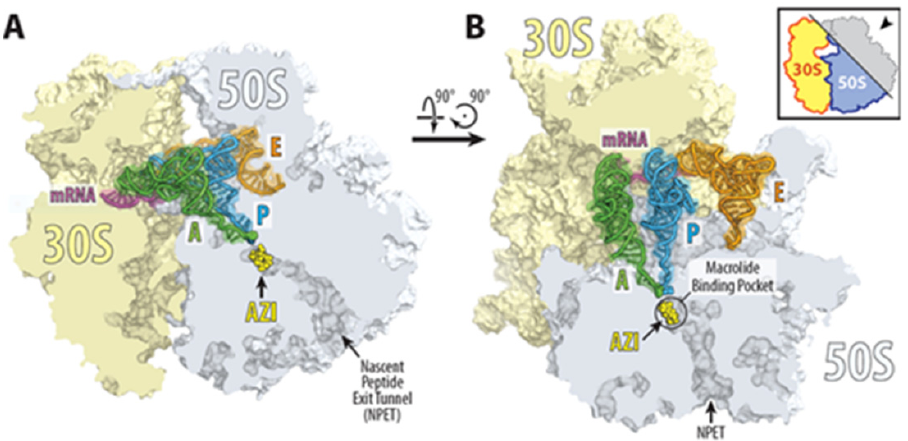
Figure 2. Structure of azithromycin in complex with the 70S ribosome carrying A-, P-, and E-site tRNAs. ( A , B ) Location of the ribosome-bound azithromycin (yellow) in the macrolide binding pocket at the entrance to the nascent peptide exit tunnel (NPET) of the 70S ribosome relative to tRNAs viewed as cross-cut sections through the ribosome. The 30S subunit is shown in light yellow, the 50S subunit is in light blue, the mRNA is in magenta, and the A-, P-, and E-site tRNAs are colored green, dark blue, and orange, respectively. The phenylalanyl and formyl-methionyl moieties of the A- and P-site tRNAs are shown as spheres [15].